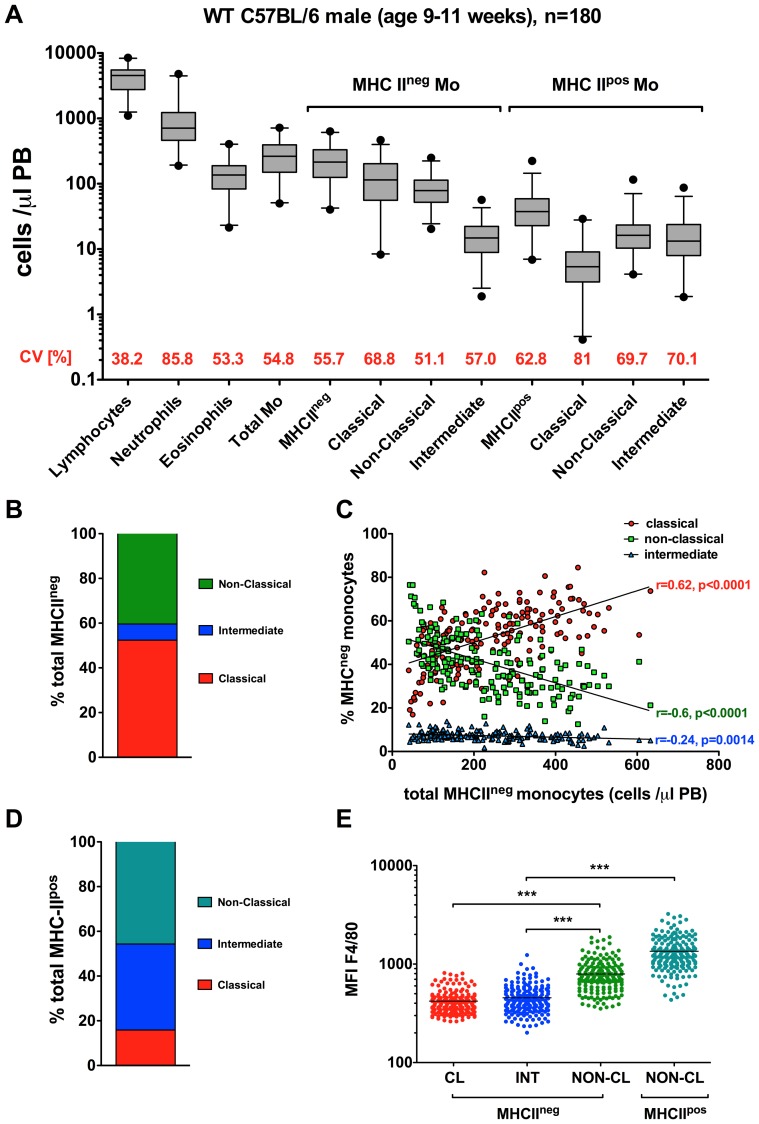
Inter-individual variability of circulating leukocyte subsets in C57BL/6 mice.(A) Cross-sectional cell frequency analysis of 180 gender- and age-matched wild-type (WT) mice. Box-and-whiskers plots of the absolute cell numbers. The box shows the 25th to 75th percentiles, and the line in the box indicates the median value. Horizontal bars outside the box indicate 10th to 90th percentiles and the circles indicate 1st to 99th percentiles. (CV – standard deviation/mean). (B) Frequencies of main monocyte subsets in WT mice as based on Ly6C/CD43 classification are displayed. (C) Occurrence of monocytosis in WT animals depends on shifts towards classical (Ly6ChiCD43low) phenotype. (D) Analysis of MHC-II-pos compartment reveals predominance of “non-classical” (Ly6ClowCD43high) and “intermediate” phenotype. (D) Mean fluorescence intensity (MFI) for F4/80 in the major monocyte subsets in WT mice.